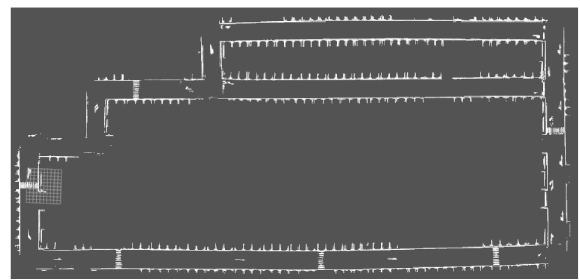
Figure 14: Global optimized semantic